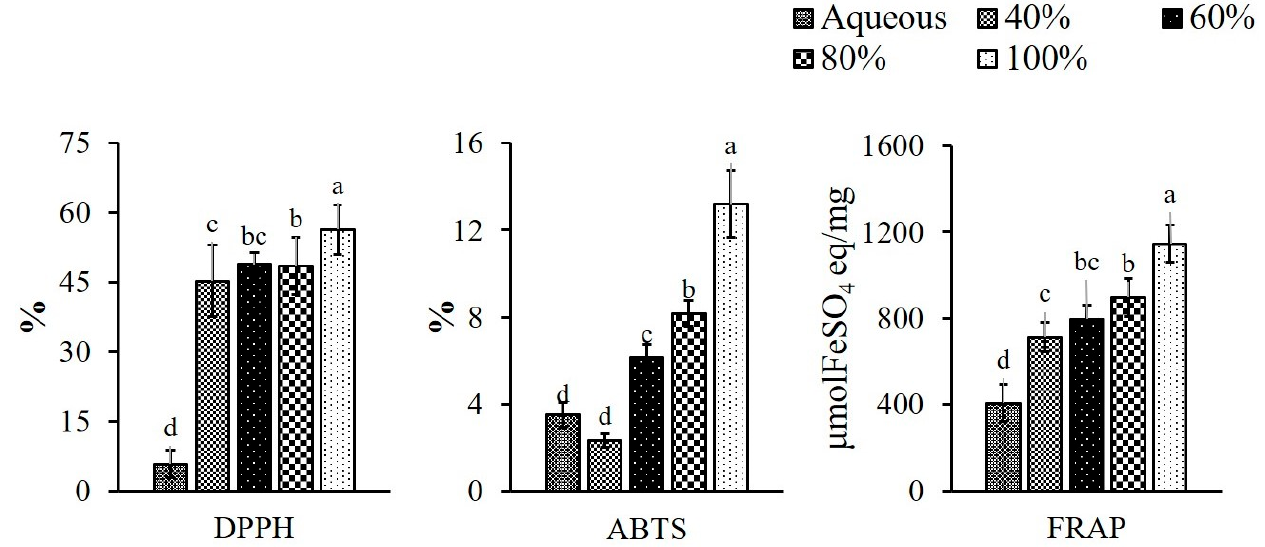
Figure 2. Antioxidative potentials of pineapple peel extracts (PPE); where DPPH—2,2-Diphenyl-1-picrylhydrazyl; ABTS—2, 2 ′ -Azino-Bis-3-Ethylbenzothiazoline-6-Sulfonic Acid; FRAP—ferric re- ducing antioxidant power. Different letters (a, b, c, etc.) on the bars indicate significant differences ( p < 0.05).